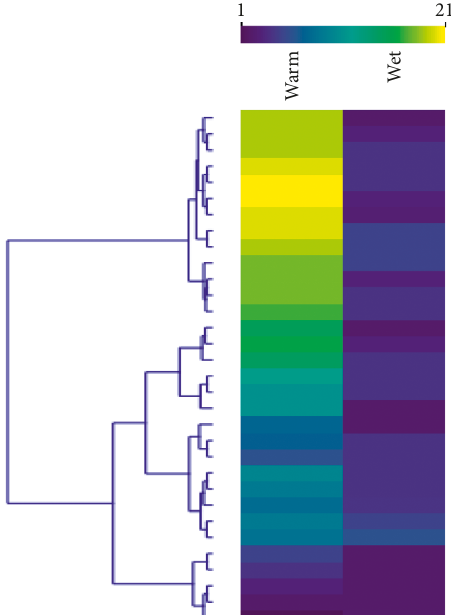
Figure 9: Heatmap for the relationship between general body temperament (wet and warm) and uterine dystemperament (wet and warm) in abnormal vaginal discharge.